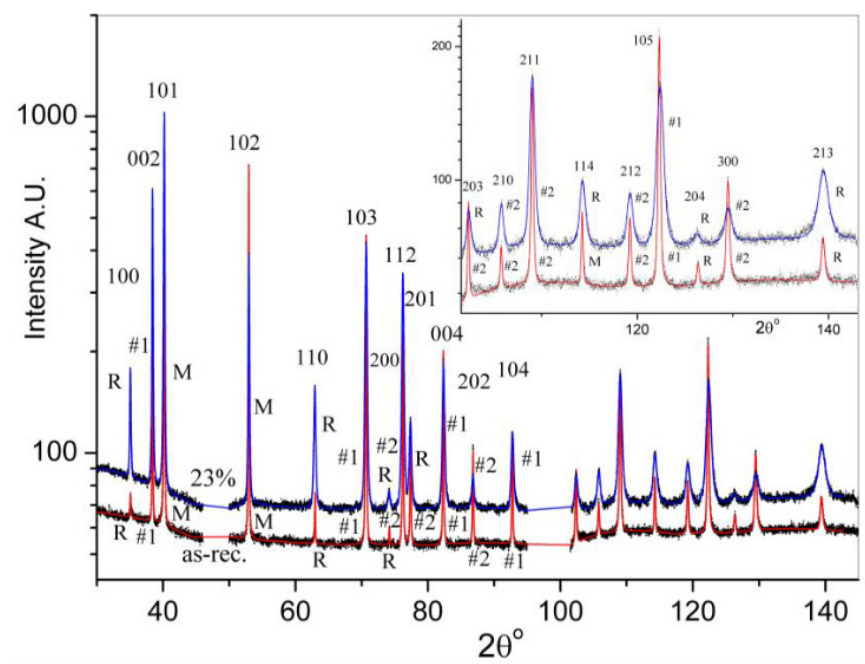
Figure 7. Measured (black dots) and fitted (solid lines) di ff raction patterns of the as-received and the 23% tensile-deformed specimens corresponding to the ND-A sample orientation with a logarithmic intensity scale. The marks indicate that a particular hkl peak is assigned to belong to one of the two major (#1 or #2) or the random (R) texture components or considered to be mixed (M). The inset is the enlarged part of the high angle section of the pattern. Table 4. χ values from measurements on di ff erently cut surfaces gathered for TSDPs in the case of 23% tensile-deformed specimen. The corresponding surfaces where the peaks used for TSDPs were measured are